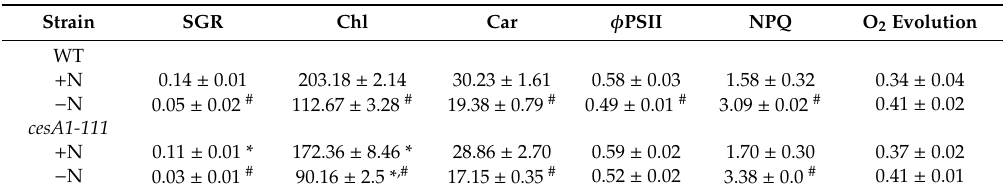
Table 1. Changes in the specific growth rate (SGR, d − 1 ), cell size, chlorophyll a (Chl) and total carotenoid (Car) content (fg cell − 1 ), e ff ective quantum yield of photosystem II ( φ PSII), nonradiative dissipation of the absorbed light via heat (NPQ), and O 2 evolution rate (mmolO 2 g Chl –1 h –1 ) under